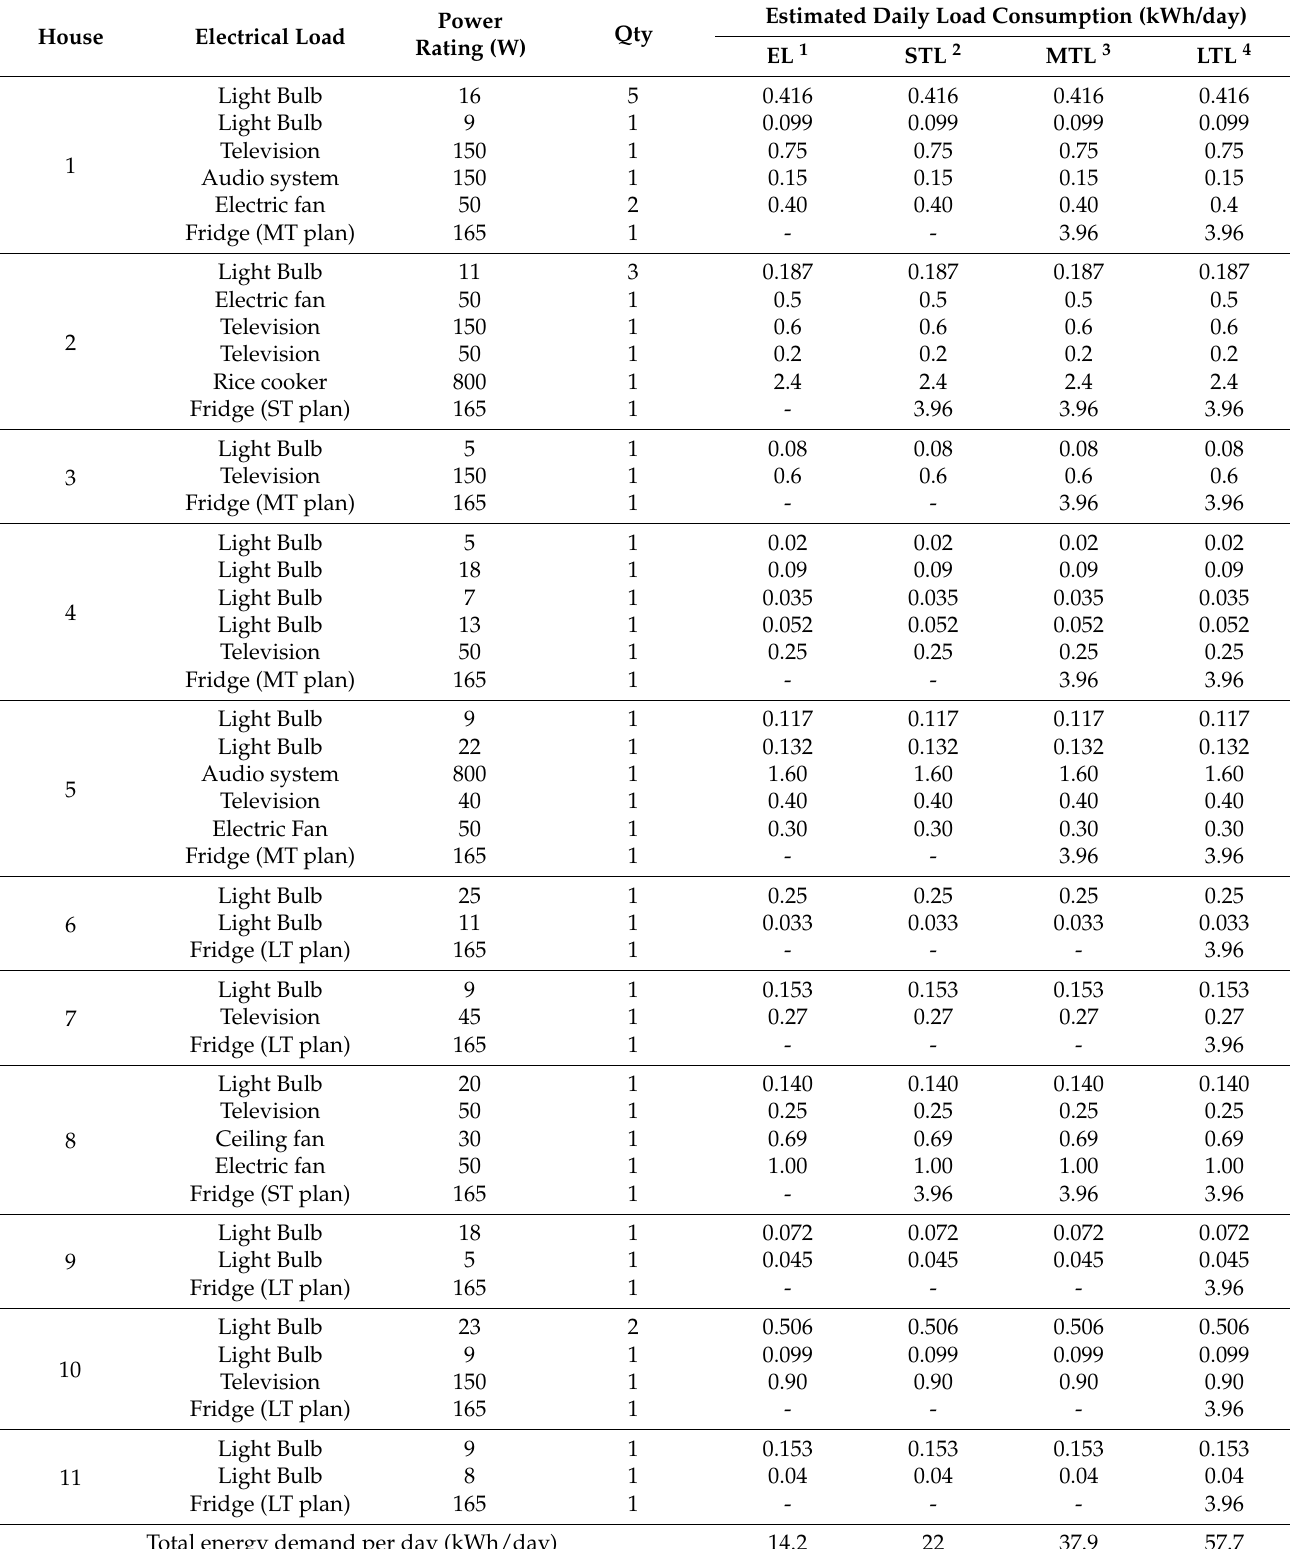
Table 2. Estimated daily energy consumption for the 11